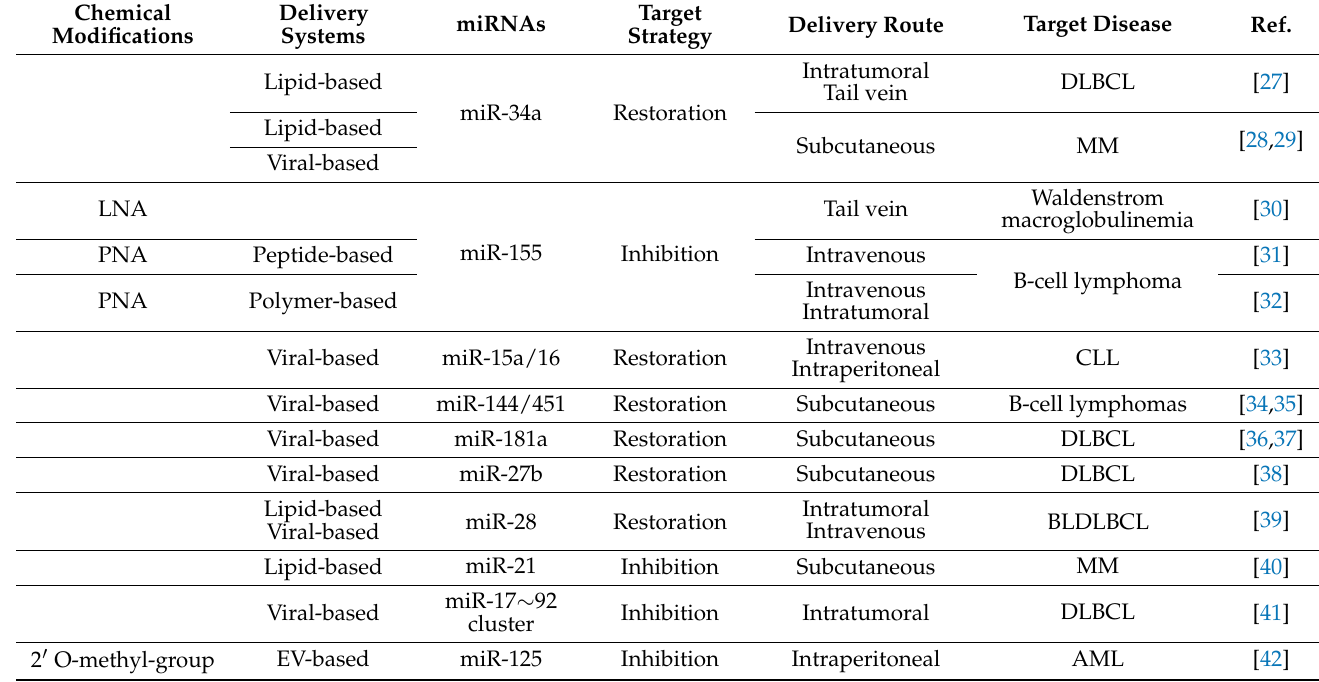
Table 1. Summary of the miRNA mimics or inhibitors tested in